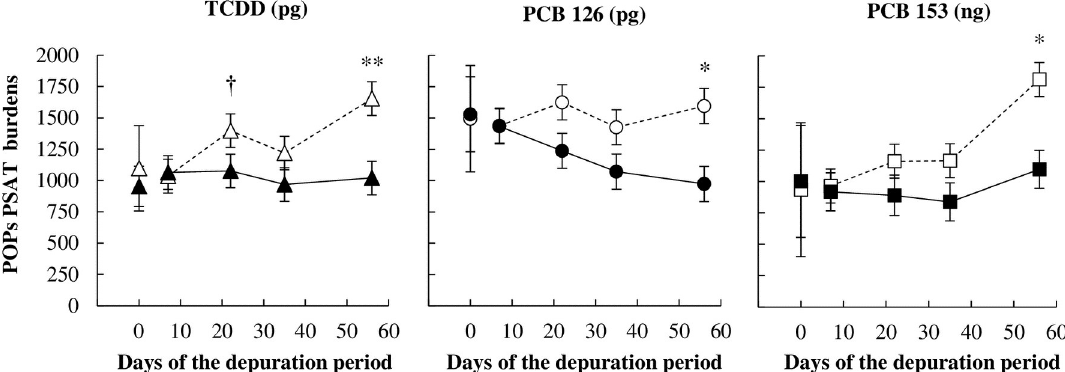
Fig 4. Time pattern kinetics of TCDD, PCB 126 and 153 pericaudal subcutaneous adipose tissue (PSAT) burdens in ewes receiving a control well-fed and non-supplemented treatment (CTL: Δ , � , □ ) or an underfed and mineral oil supplemented treatment (UFMO: ▲ , ● , ■ ). Each point represents the least-squares mean, and error bars indicate SEM except at day 0, for which they represent the mean and SE. The � and �� symbols indicate a significant ( P � 0.05 and P � 0.01, respectively) and † a tendency toward significance ( P � 0.10) for treatment effect on the considered